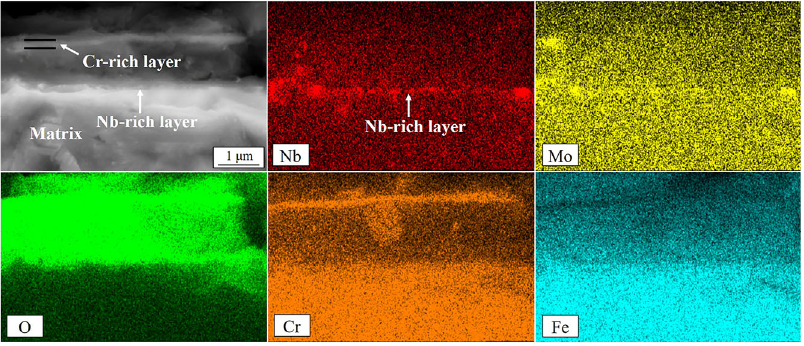
Figure 6. Cross-sectional SEM with corresponding EDS mapping images of sample S1 after exposure to CO 2 at 650 °C under 3.5 MPa for 1000 h.